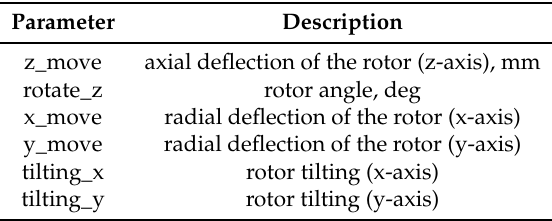
Table 1. Simulation